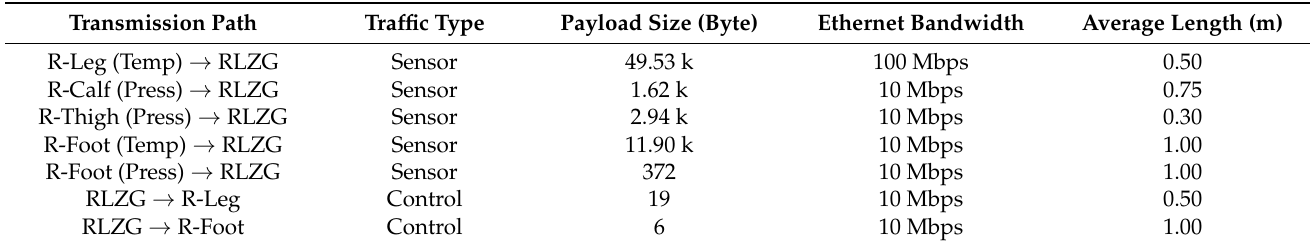
Table 10. Data transmission link parameters of the ZIRA Right Leg and Foot